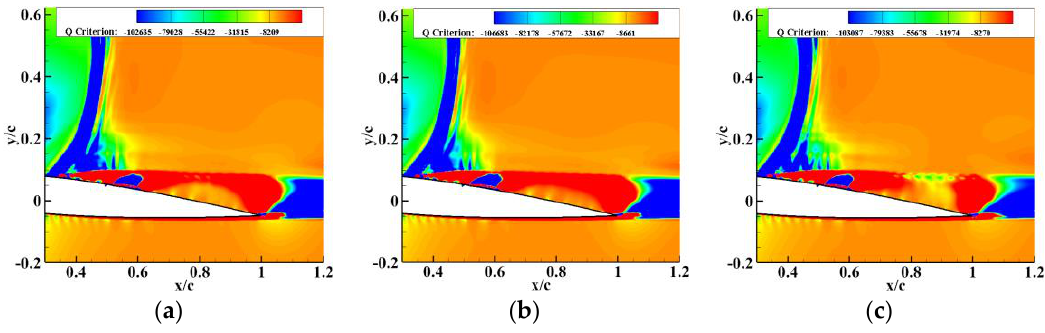
Figure 25. Q-criterion results for the “ 51% x/c ” case. ( a ) Maximum lift; ( b ) median lift; and ( c ) minimum lift.